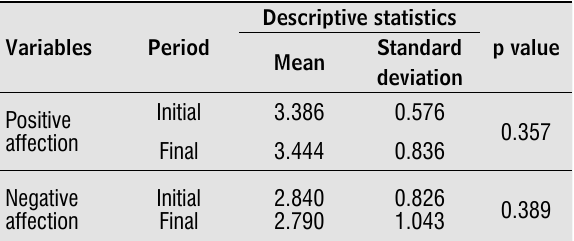
Table 5 – Initial and final comparison of the Well-being Scale (SWB) through the Student t test at 5 % level of